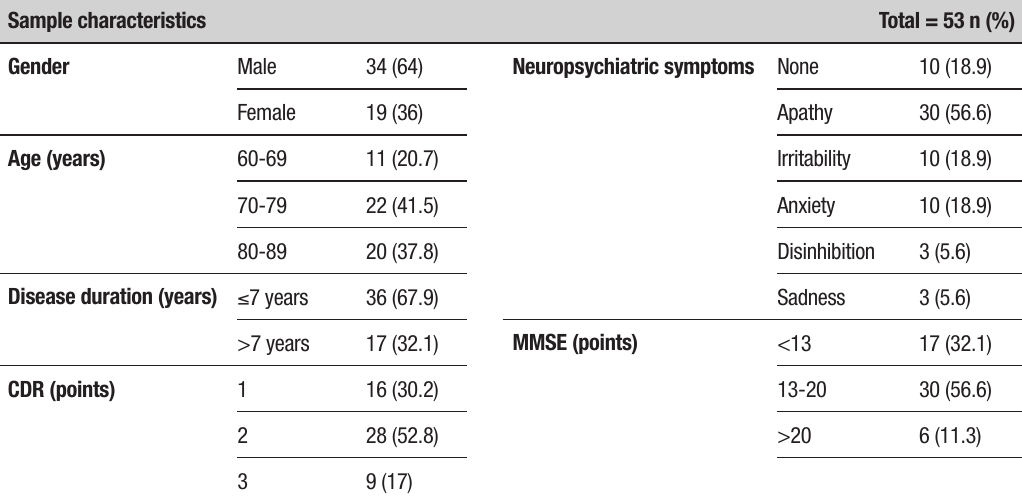
Table 1. Distribution of clinical and epidemiological characteristics for the studied sample. Sample